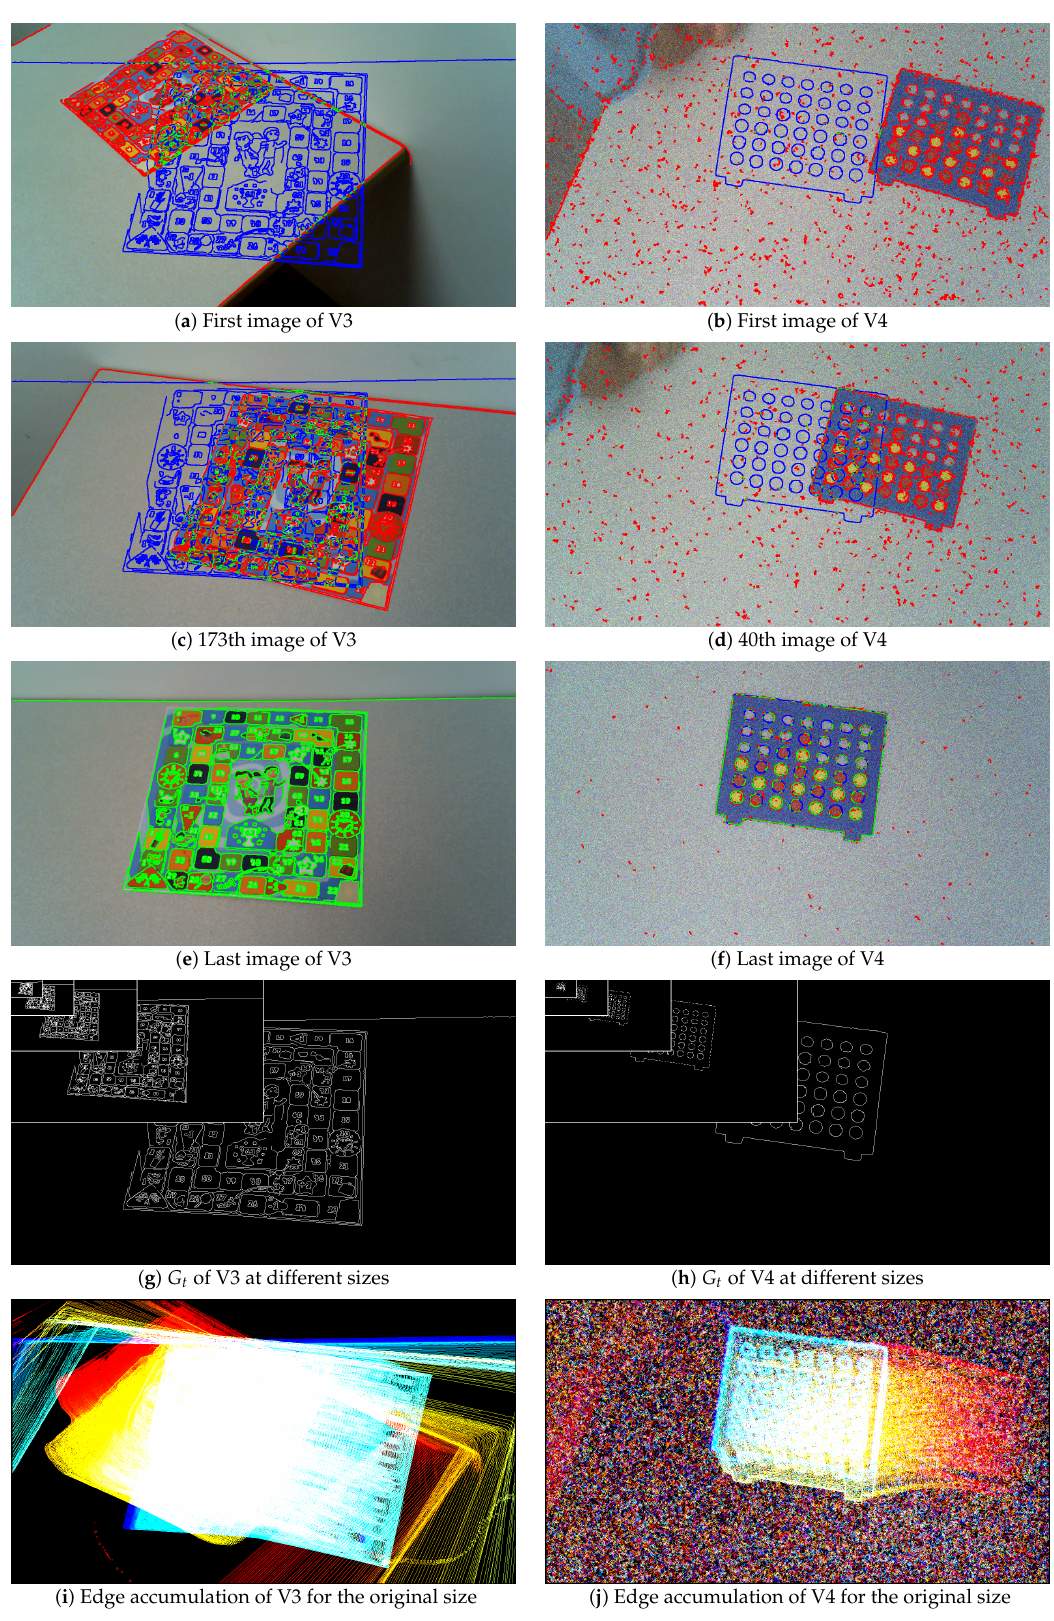
Figure 6. The first images of videos V3 and V4 with their G t at different sizes: original size (1280 × 720), 4 × , 16 × , 64 × and 256 × reduced (640 × 360, 320 × 180, 160 × 90 and 80 ×